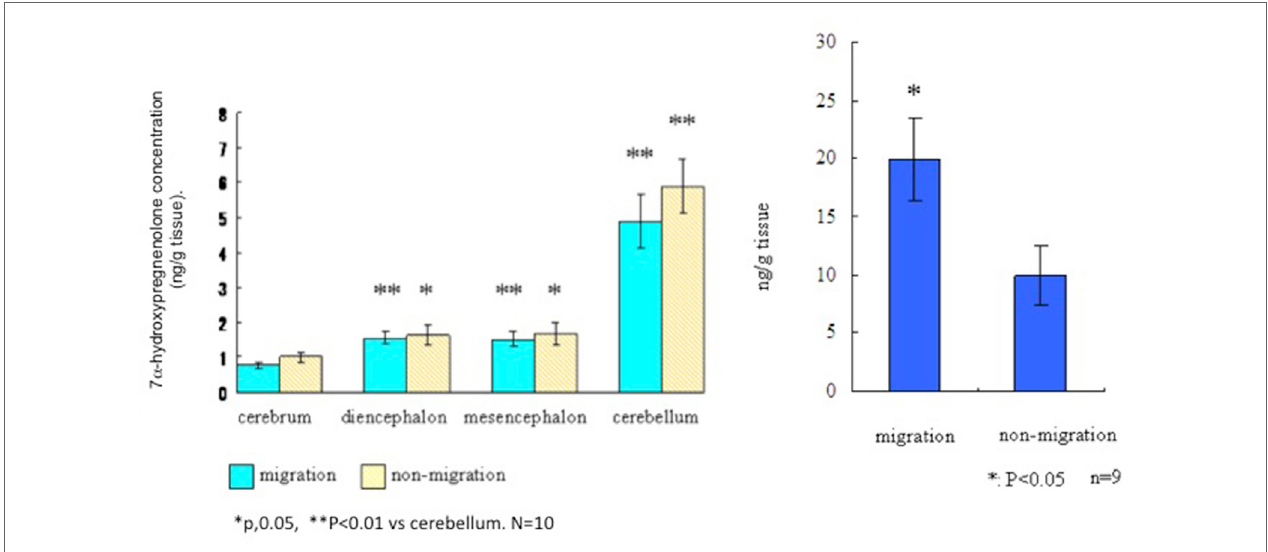
FigUre 3 | Left panel. Synthesis of 7 α -hydroxypregnenolone in different brain regions of the white-crowned sparrow, Zonotrichia leucophrys gambelii . Right panel. Whole brain concentrations of 7 α -hydroxypregnenolone in white-crowned sparrows, in migratory and non-migratory life history